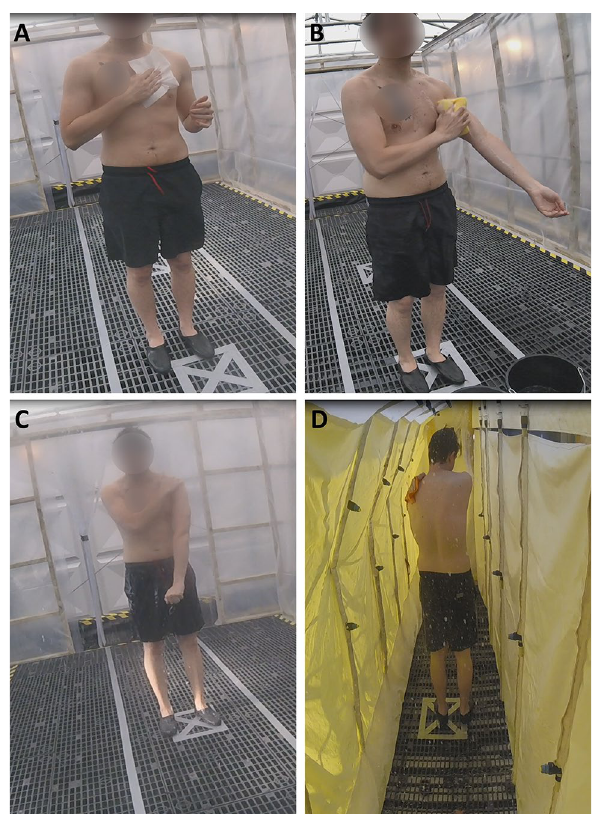
Figure 1. A participant undergoing each of the decontamination conditions. ( A ) Dry decontamination using white roll sheets, ( B ) RWR using a sponge, bucket and soapy water, ( C ) interim using a bespoke showering corridor and ( D ) SOR using an